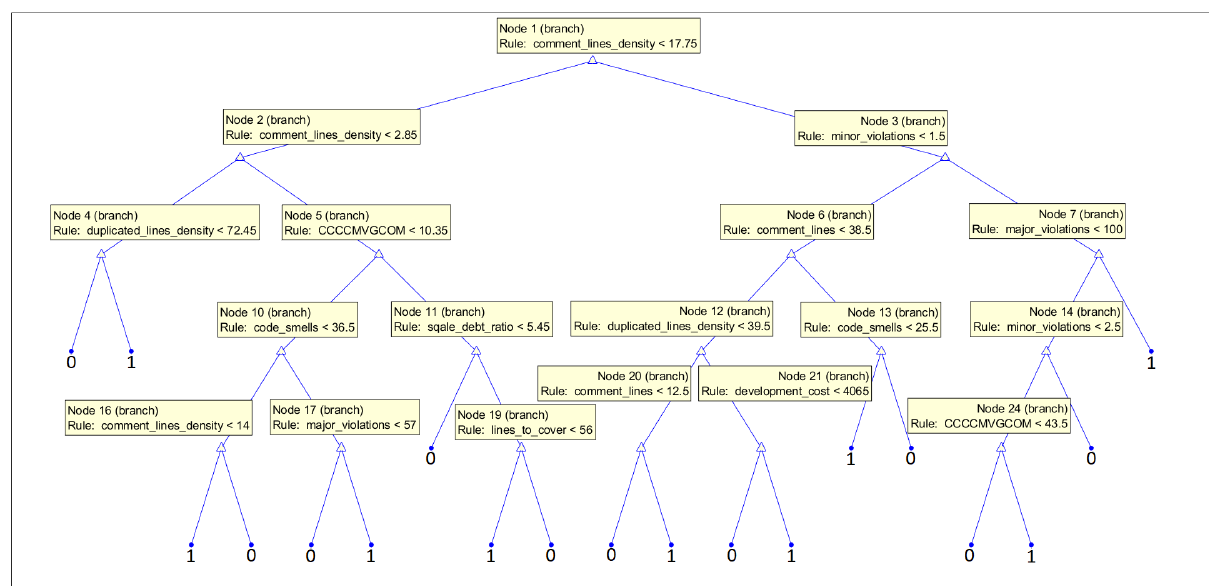
Figure 16. Medium tree based given all 33 features as the input for the subset with CWE-399 vulnerabilities